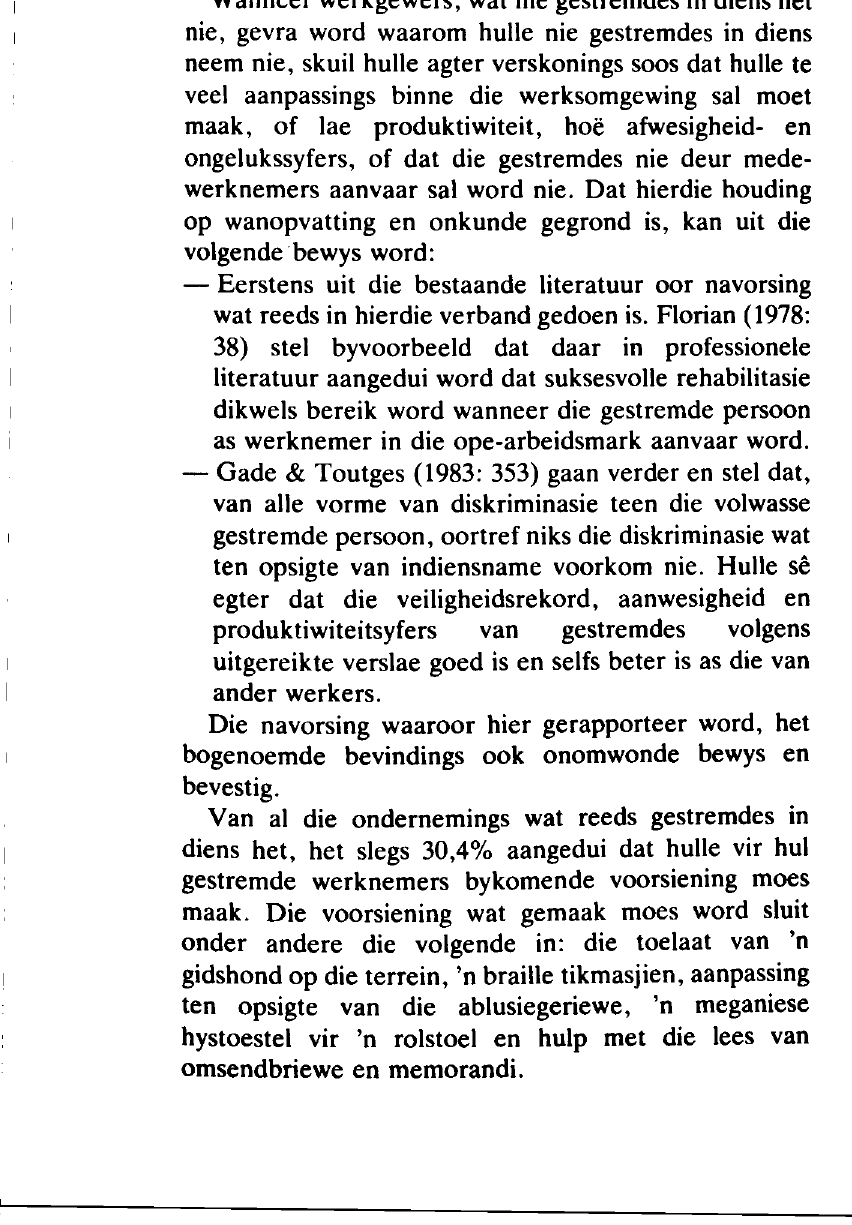
Figuur 2c Geneigdheid tot afwesigheid onder gestremdes